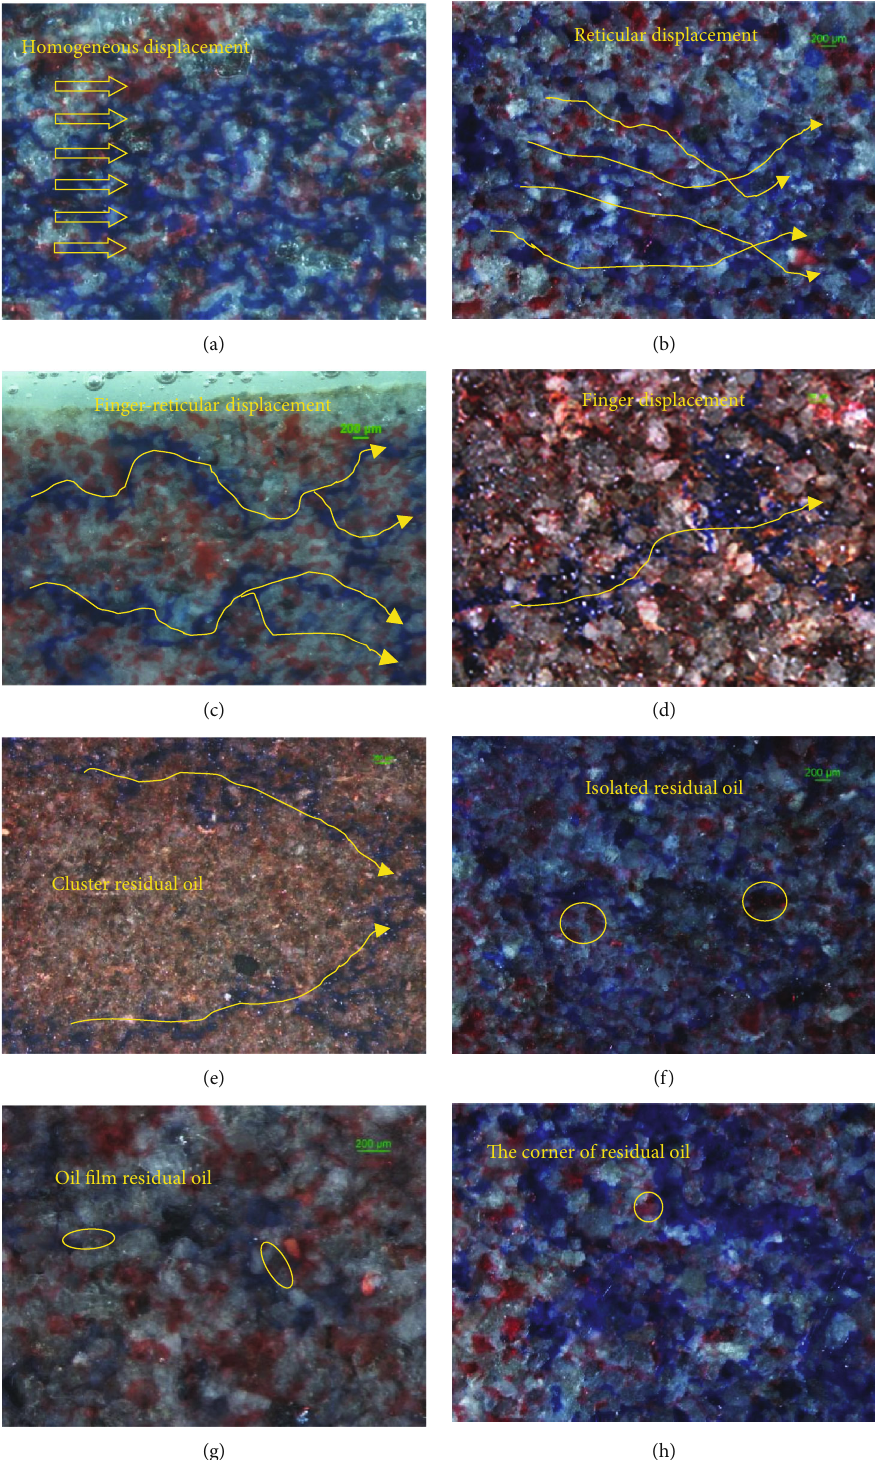
Figure 5: The characteristics of microscopic photos in water fl ooding experiments with the real sandstone micromodel. (a) Uniform displacement (Y245, 2111.60m); (b) reticular displacement (J116, 2101.96m); (c) fi nger-reticular displacement (Y215, 2118.47m); (d) fi nger displacement(X29, 2331.00m); (e) cluster residual oil (J43, 2041.93m); (f) isolated residual oil (C335, 2303.72m); (g) oil fi lm residual oil (L37, 2285.47m); (h) the corner of residual oil (J43,